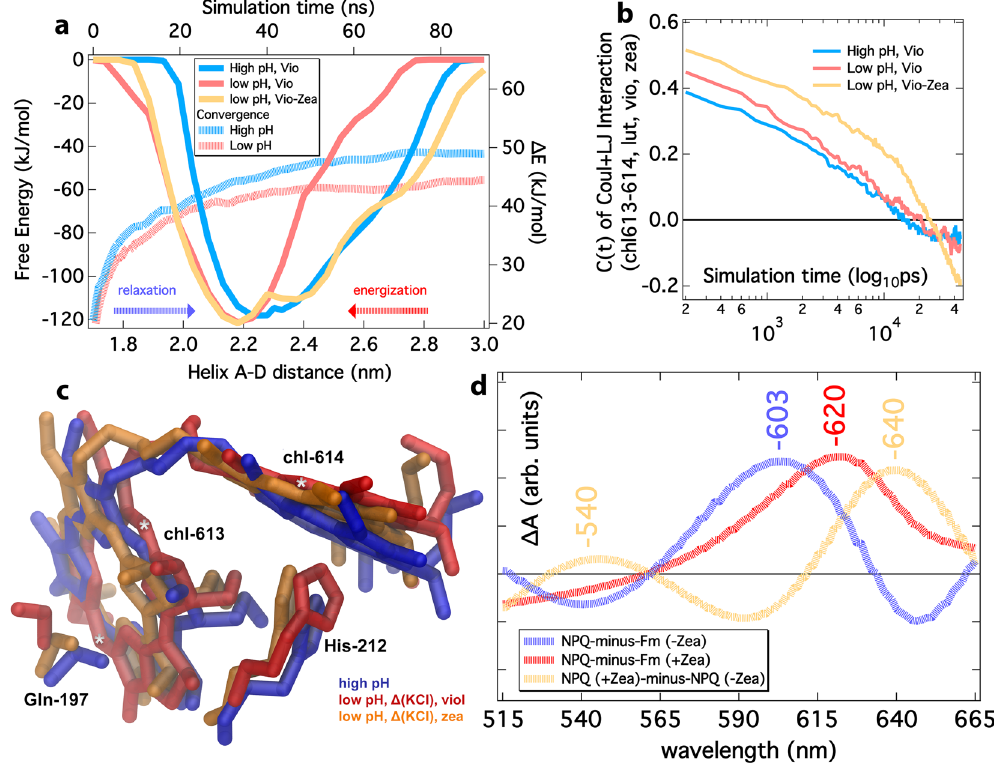
Figure 2. Free Energy profiles, Structures and Absorption Spectra of the Chl-613/Chl-614 pair in the major Light Harvesting Complex (LHCII) from spinach; relaxed, or under NPQ conditions. ( a ) The concatenated free energy profiles (left-bottom axes) for the major LHCII from spinach, at different lumen states – high pH (0.0/0.5 M Δ (KCl)) and low pH (0.0/0.5 M Δ (KCl) – and the violaxanthin (Vio) – Zeaxanthin (Zea) replacement effect. The average ΔΕ convergence (right-top axes) is also shown over the simulation time selectively for low and high pH between two regions (2.0–2.5 nm/2.8–3.0 nm) of the Free Energy profiles (dashed red-blue lines). ( b ) Autocorrelation Functions C(t) of the sum of Coulomb (Coul) and van der Waals (LJ) interaction energies between the pigments next to helix-D: chl613, chl614, violaxanthin (Vio), or zeaxanthin (Zea), and lutein 1 (Lut1). ( c ) Ab-Initio geometry optimized ground-state structures of the two pigments adjacent to helix-D (chl-613/614) from different lumen states: high pH with Violaxanthin (Vio), and low pH with Vio or Zeaxanthin (Zea). The axial ligands are treated also at the ab initio level (His-212 for chl614 and Gln-197 for chl613). ( d ) Relative Absorption Difference Spectra calculated at the TDDFT level with Fourier Transform of the dipoles after the electric field perturbation is applied to the Kohn-Sham states in x, y and z directions and Lorenzian fit (convolution) of the peaks. The difference absorption spectra of the chl-613/614 pair orientations are shown as NPQ-minus-Fm ( − Zea) for low pH (Vio)-minus-high pH (Vio), as NPQ- minus-Fm ( + Zea) for low pH (Zea)-minus-high pH (Vio) and NPQ ( + zea)-minus-NPQ ( − Zea) for low pH (Zea)-minus-low pH